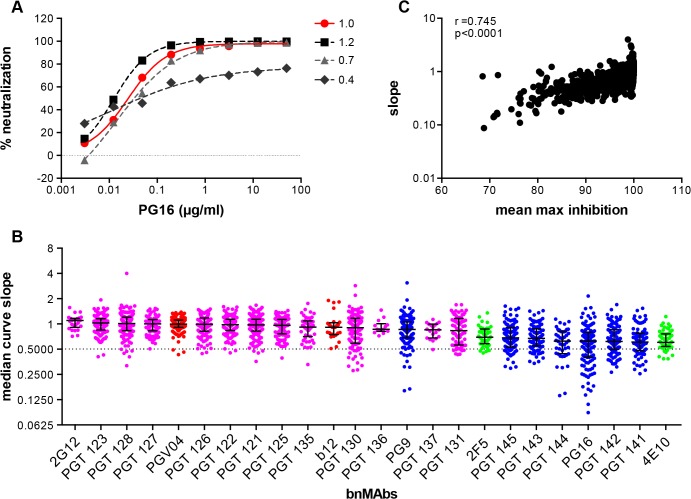
Deviation from standard dose-response curve by bnMAbs in a U87 target cell assay.(A) Representative experiment of PG16 neutralization of HIV pseudoviruses: MGRM-Chronic-B-017.c13, slope = 1.0 (red circle); MGRM-G-022.c02, slope = 1.2 (black square); MGRM-Chronic-B-006.c06, slope = 0.7 (light gray triangle); and MGRM-AG-011.c15, slope = 0.4 (dark gray diamond). (B) The neutralization curve slopes were determined for data from Fig 1A. BnMAbs are ordered according to decreasing medians. The bars represent the medians and the whiskered bars represent the interquartile range. The data points are colored according to which site the bnMAb targets: high-mannose patch (magenta), CD4bs (red), V2 apex (blue), and MPER (green). The dotted line denotes a slope of 0.5. (C) The neutralization curve slope value of each bnMAb for each virus on the y-axis is plotted against the corresponding MPN for each virus-bnMAb pair on the x-axis. Spearman correlation was used for statistical analysis. The Spearman’s rank correlation coefficient was calculated at 0.745 and the P value <0.0001.